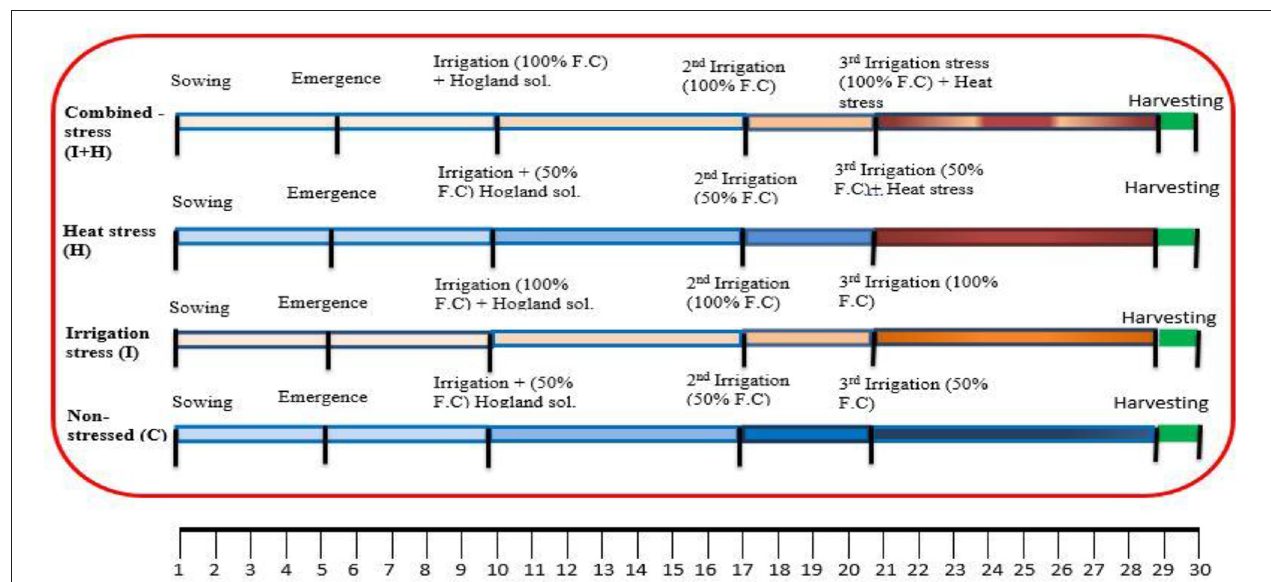
FIGURE 1 | Scheme diagram of protocol followed for screening against irrigation (I), heat (H), and combined (I + H) stress on Chickpea seedlings, irrigation stress at 100% field capacity, heat stress 38/17 ◦ C, combined stress (38/17 ◦ C + 100% F.C), 1/8th strength Hoagland Solution.